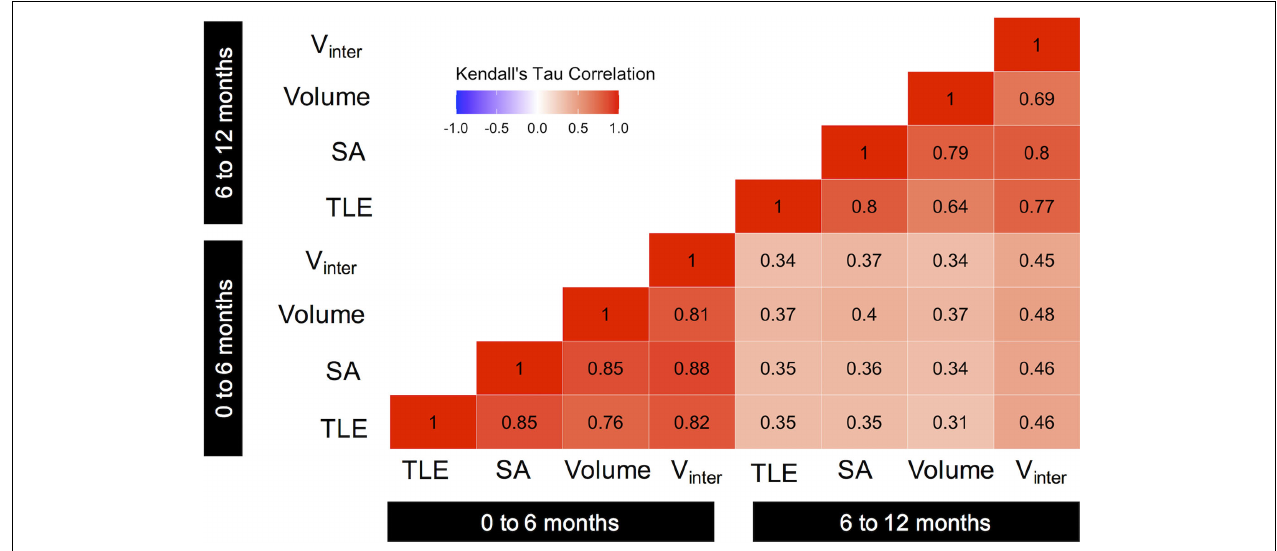
FIGURE 2 | Correlation matrix showing the relationships among growth in traits over time. Values indicate Kendall’s tau correlation coefficient. All relationships were significant ( p < 0.05). Color indicates the magnitude and direction of the correlation.